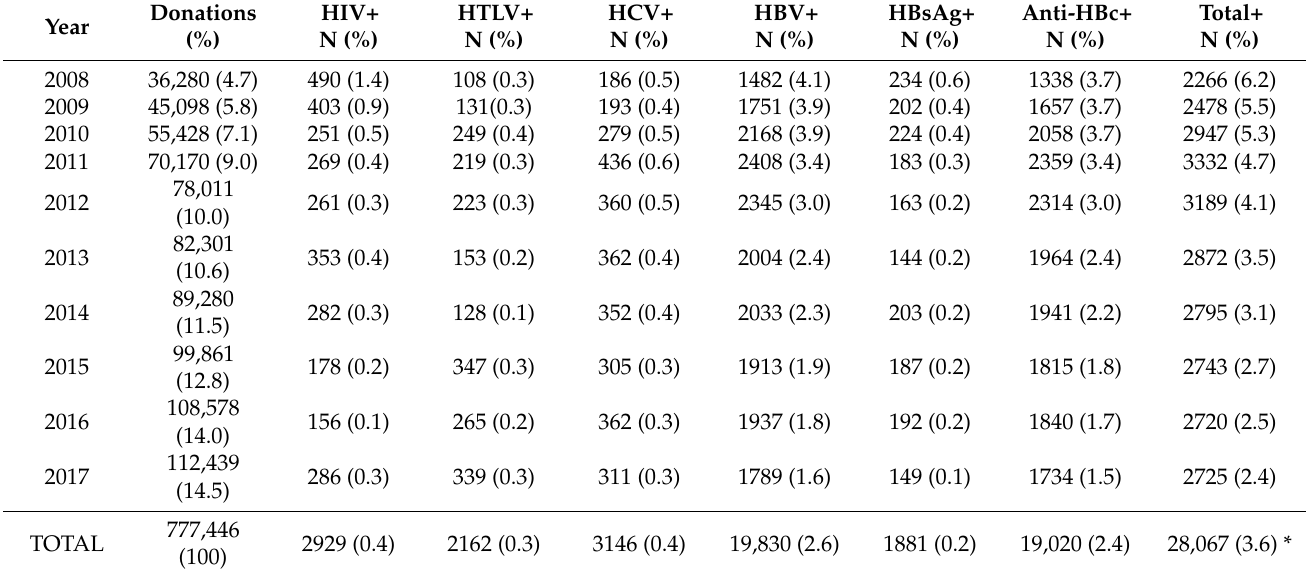
Table 3. HIV, HTLV, HCV, and HBV prevalence rates of Hemoba blood donors in the period from February/2008 to